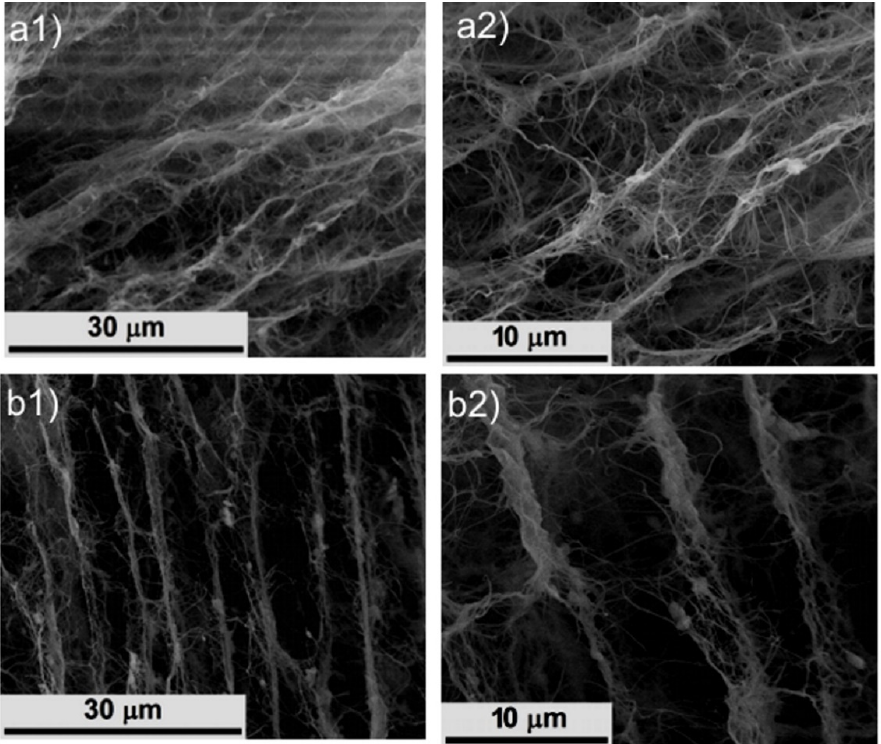
Figure 1. SEM images of native BC ( a1 , a2 ) and DABC ( b1 , b2 ) at different magnifications.